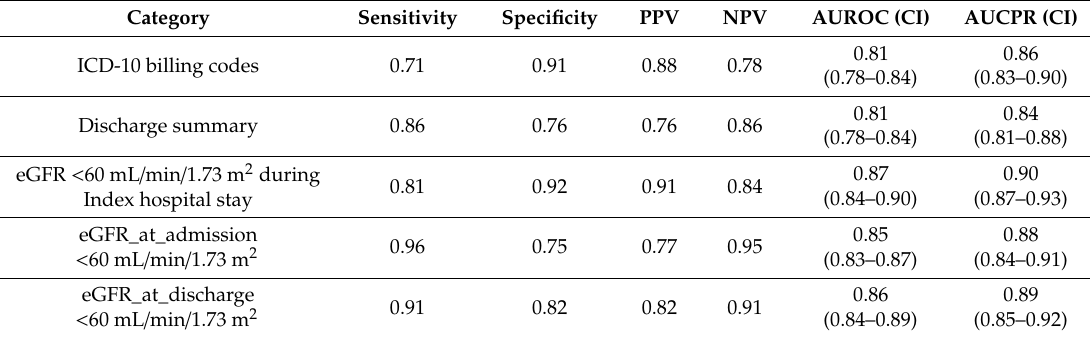
Table 4. Performance of di ff erent rules for identification of patients with CKD compared to the reference standard.